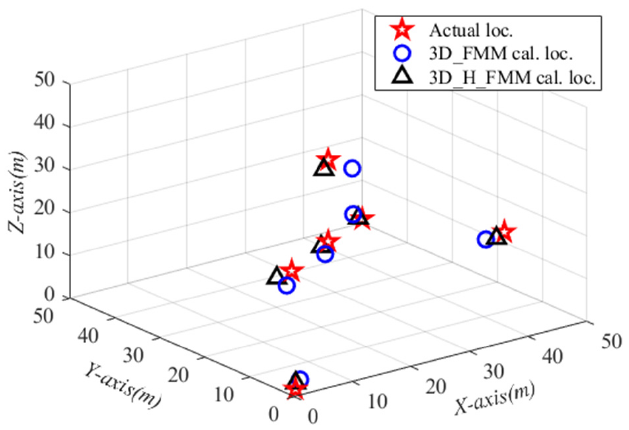
Figure 13. The localization results of microseismic sources with Case C: small-scaled inhomogeneous velocity model.